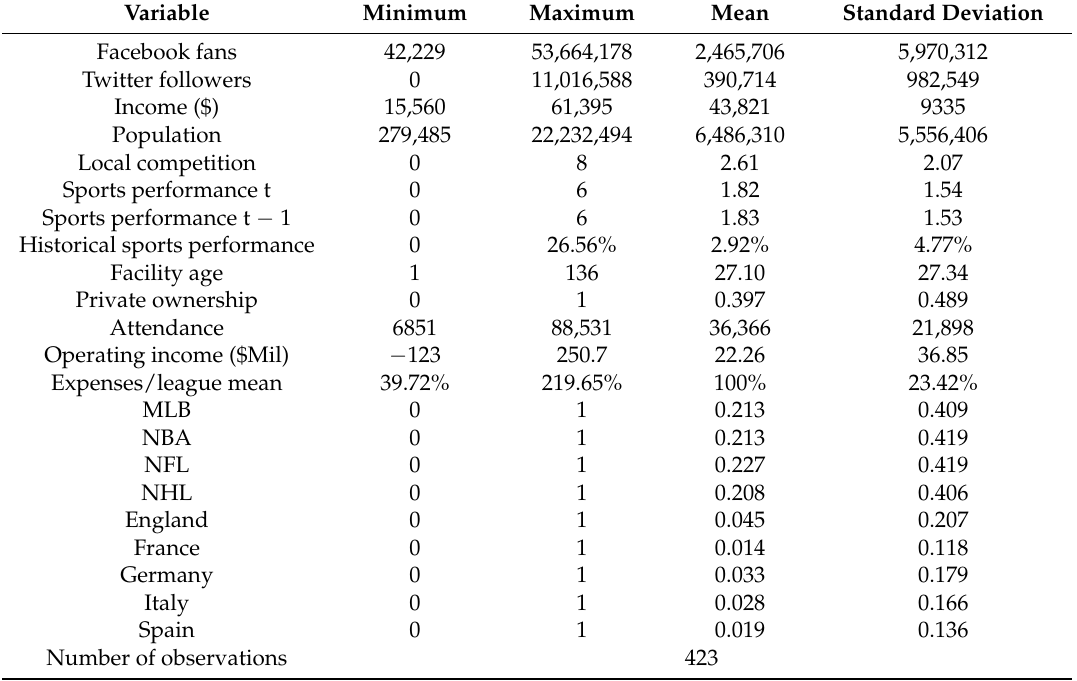
Table 1. Summary